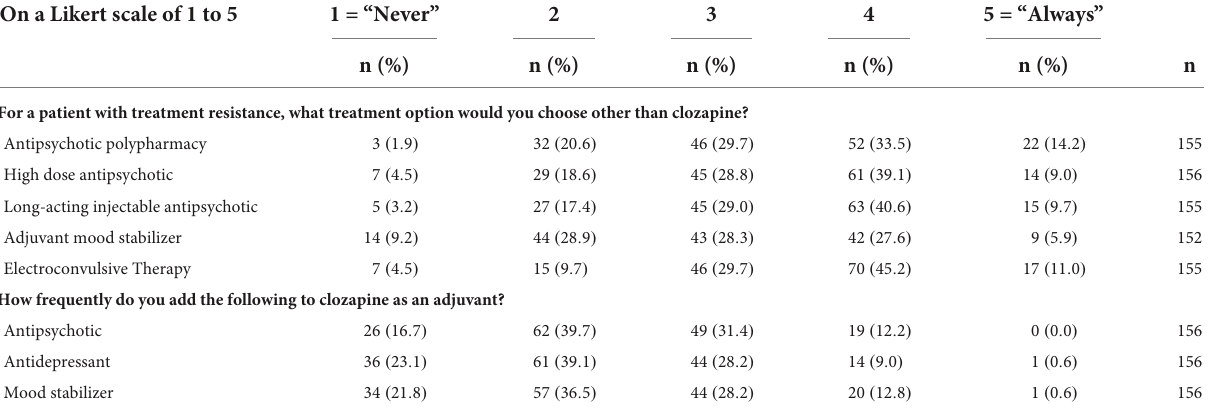
TABLE 3 Answers to questionnaire, shown as percentage of respondents who answered each question (Singapore). On a Likert scale of 1 to